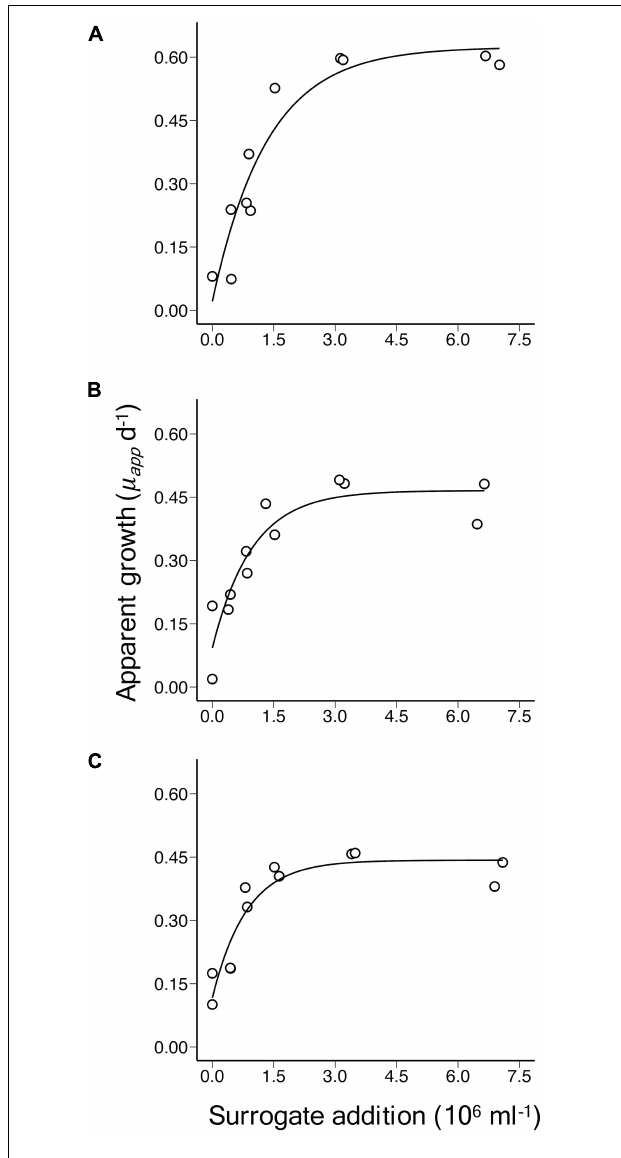
FIGURE 1 | Laboratory culture experiments of Ochromonas danica grazing on Micromonas pusilla , showing the relationship between apparent growth rate ( µ app ) of M. pusilla over 24 h vs. the initial level of addition of 2 µ m microspheres. The curves are significant fits of an asymptotic regression model and the corresponding details are shown in Table 1 for experiments (A–C)